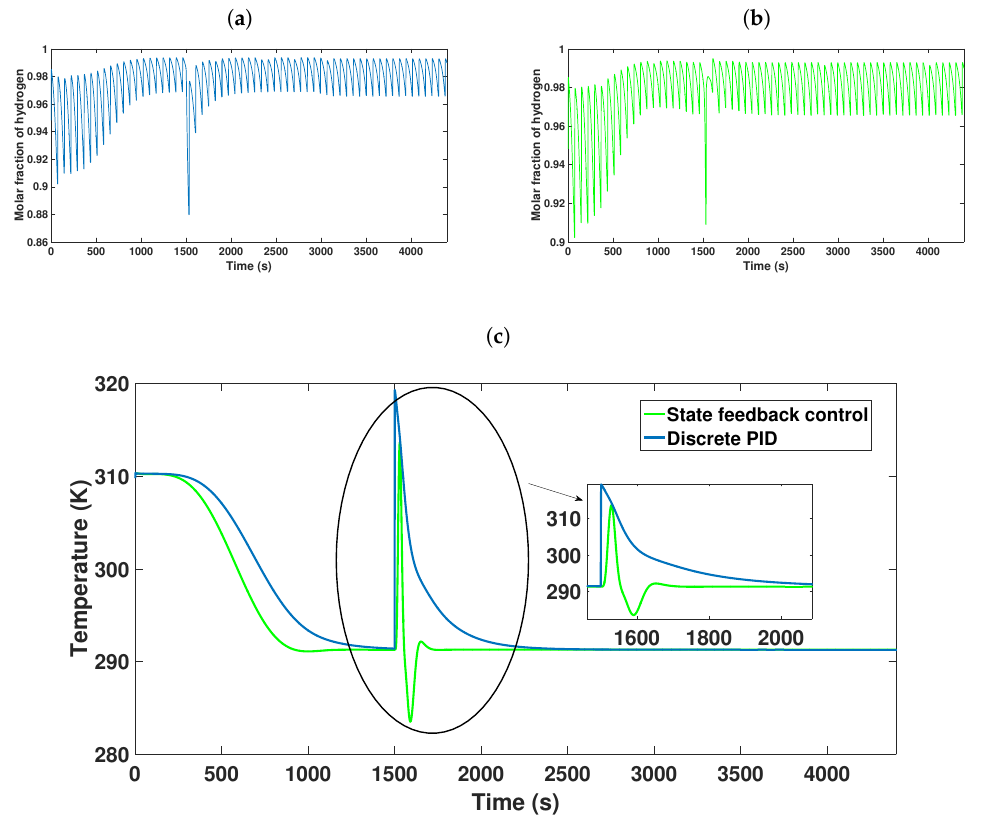
Figure 19. Validation of the controllers from a change of trajectory and the presence of a disturbance. ( a ) Purity obtained with trajectory tracking and attenuation of a disturbance from the control signals generated by the discrete PID. ( b ) Purity obtained with trajectory tracking and attenuation of a disturbance from the control signals generated by state feedback. ( c ) Discrete PID and status feedback control